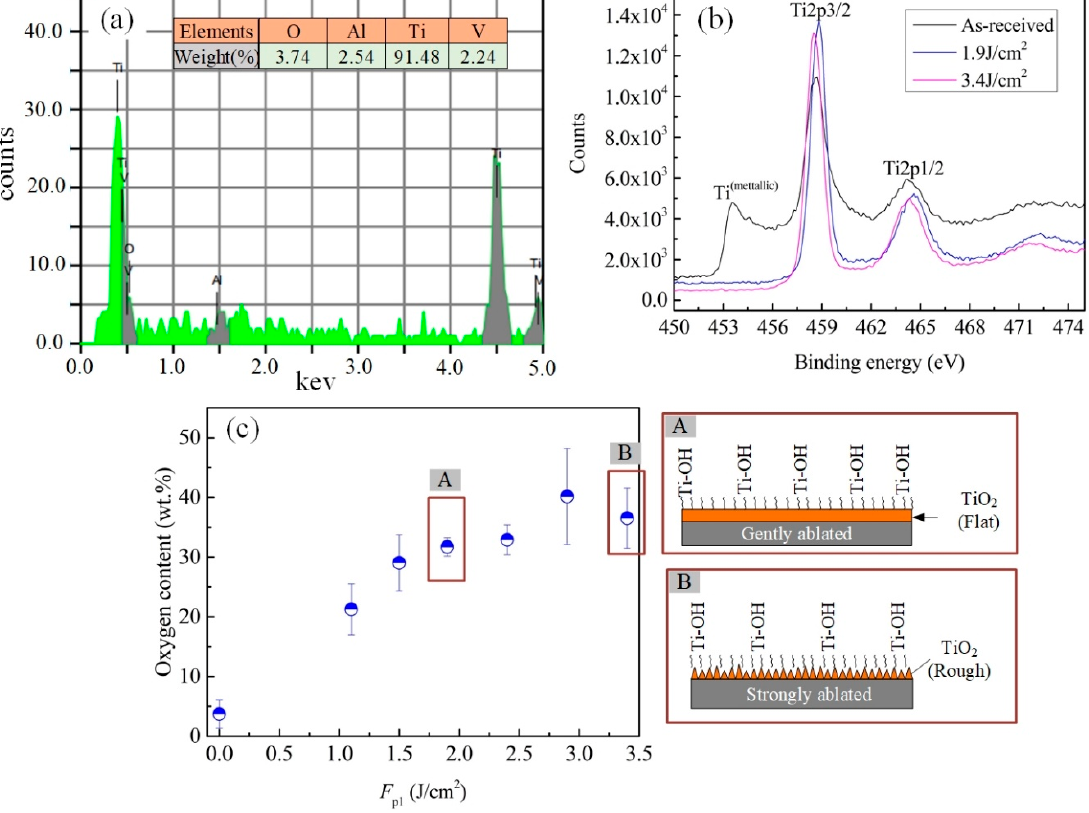
Figure 9. ( a ) EDS spectra of the as-received Ti–6Al–4V surface; ( b ) high-resolution XPS spectra (Ti2p) of the as-received and laser-irradiated Ti–6Al–4V surfaces; ( c ) effect of F p1 on the oxygen content in the laser-irradiated surfaces detected by EDS.